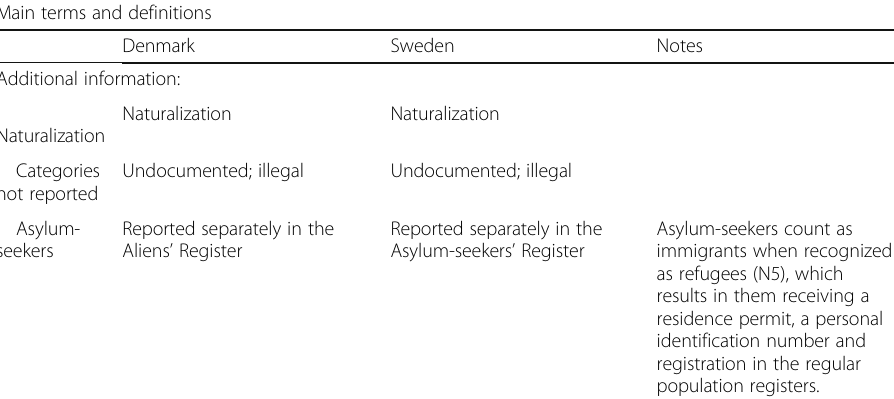
Table 1 Main terms and categories used to report on the non-native population in the official sta- tistics of Denmark and Sweden